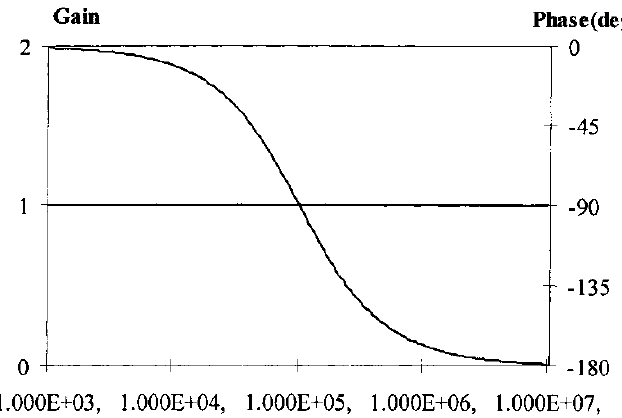
FIGURE 5 Simulated frequency response for